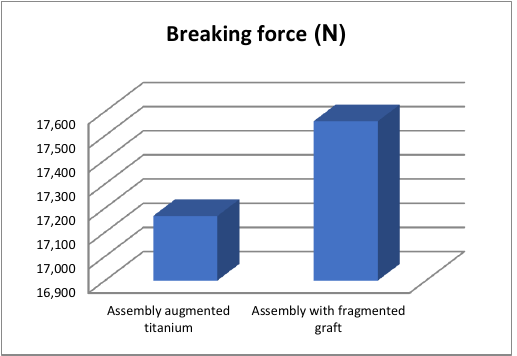
Figure 49. Comparative diagram of breaking forces in Kgf.